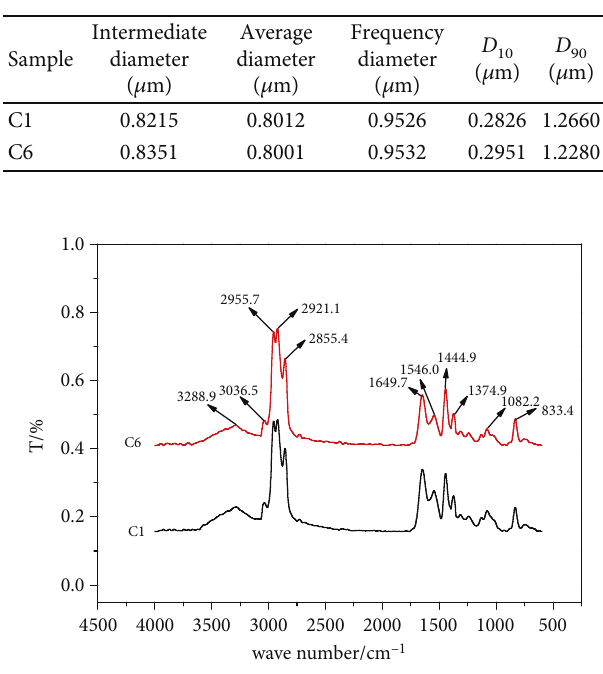
Figure 6: The FTIR spectra of CNRL raw rubber fi lm samples.